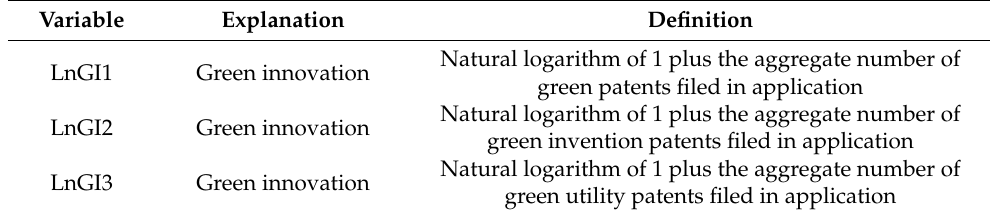
Table 1. Variable